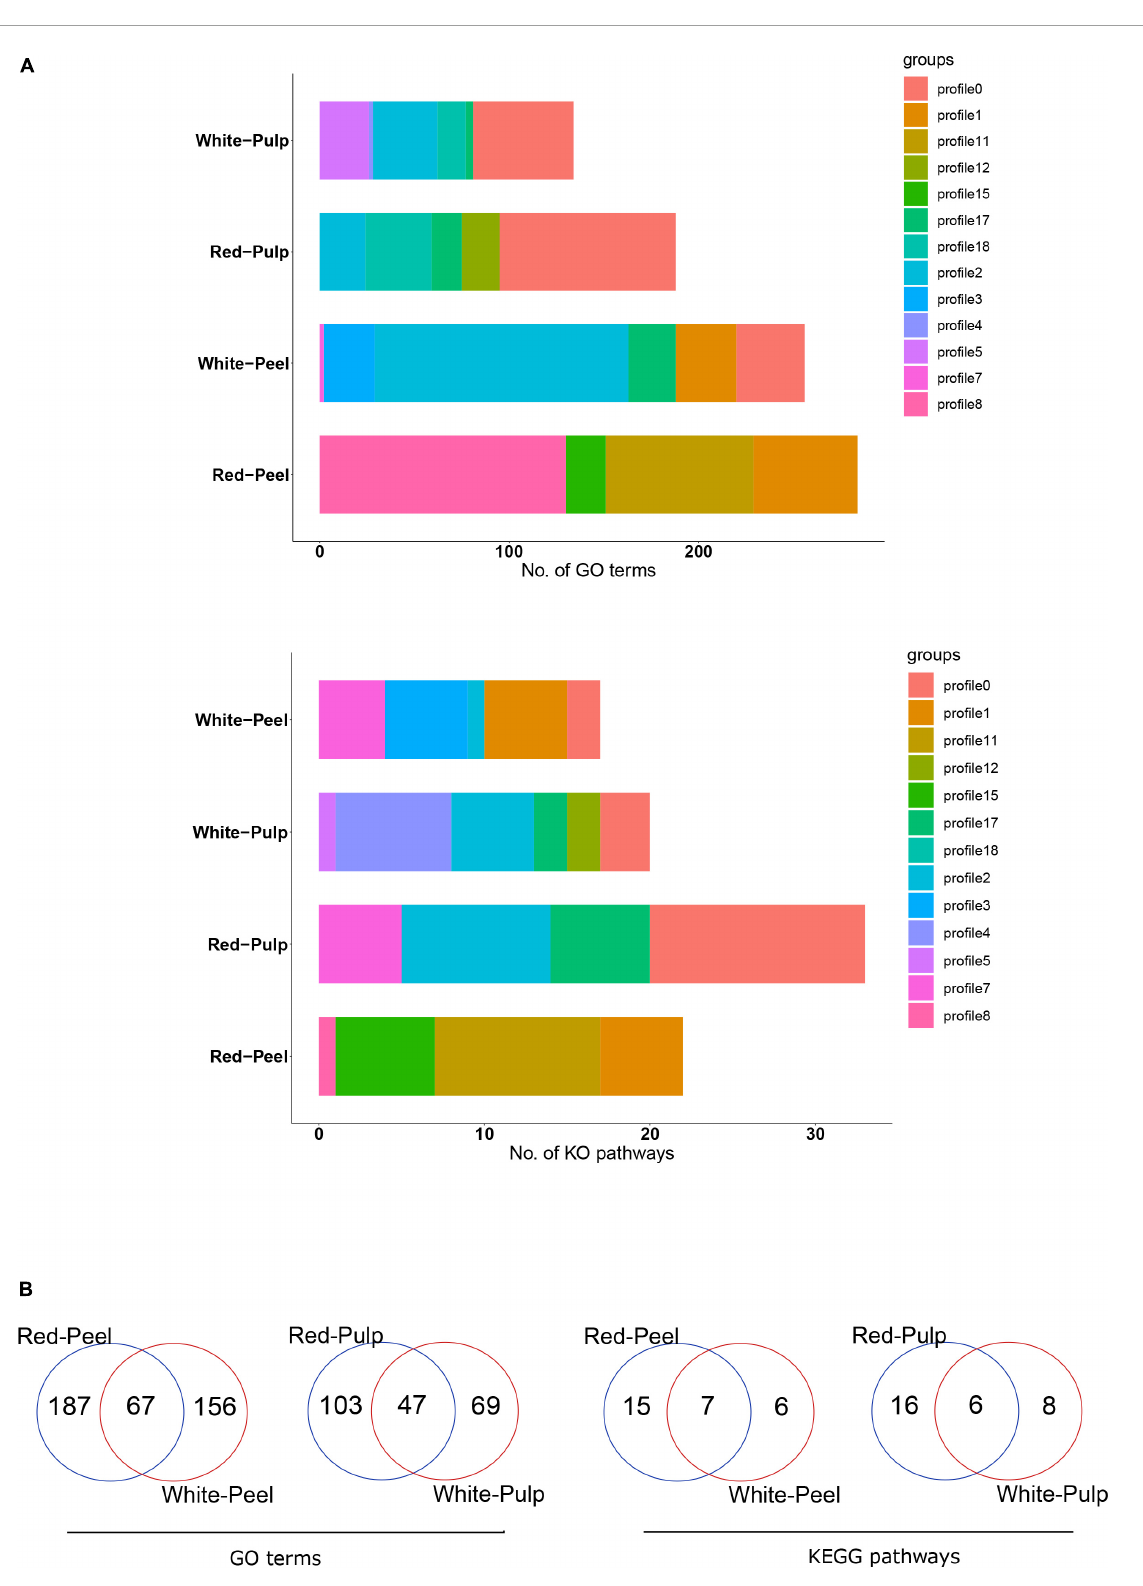
FIGURE5 Functional annotation of significant clustered-profiles. The number of enriched categories (A) and their overlap of enriched categories (B) in significant clustered-profiles are presented.